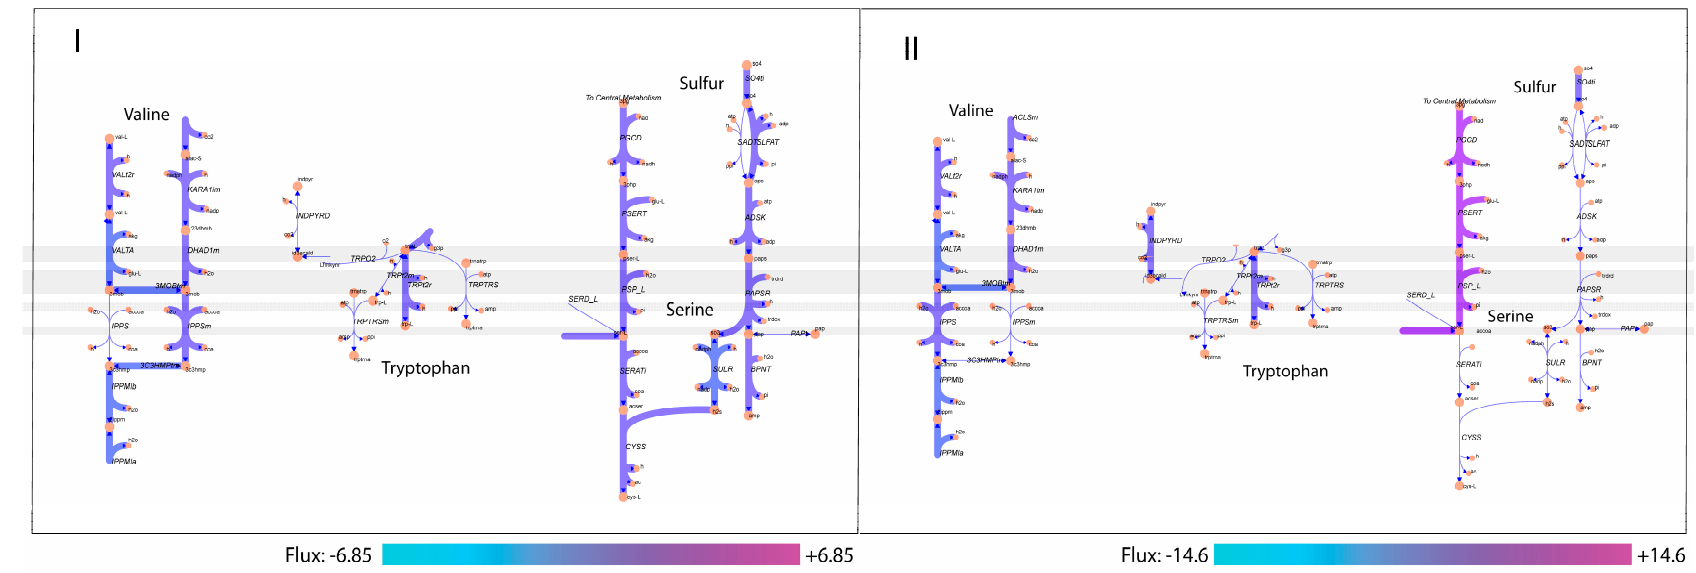
Figure 4. Network maps of amino acid and sulfur metabolism. Network fluxes were determined for Case I ( left ) and Case II ( right ) where the network illustrates the optimal solution from FBA. Note that the scales, as indicated in the legends, are different for Case I and Case II.